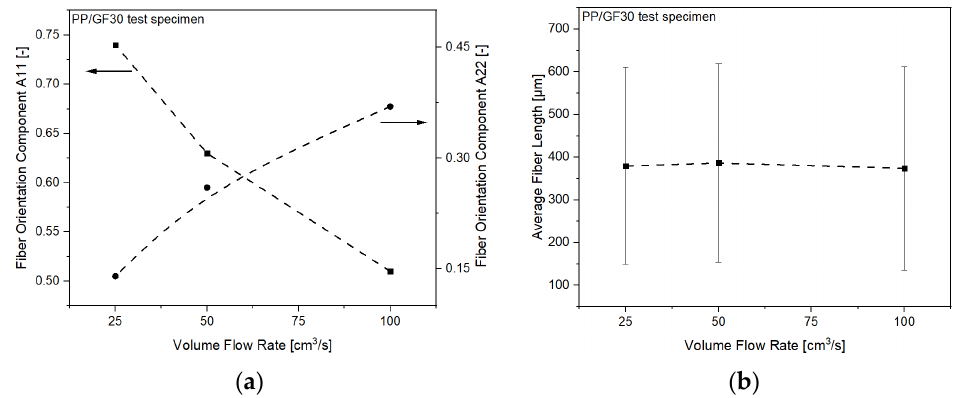
Figure 14. Morphological properties of the PP/GF30 short fiber-reinforced thermoplastic composite as a function of volume flow rate: ( a ) fiber orientation components A11 and A22 as experimentally measured by CT and ( b ) average fiber length as experimentally measured by fiber length analysis.